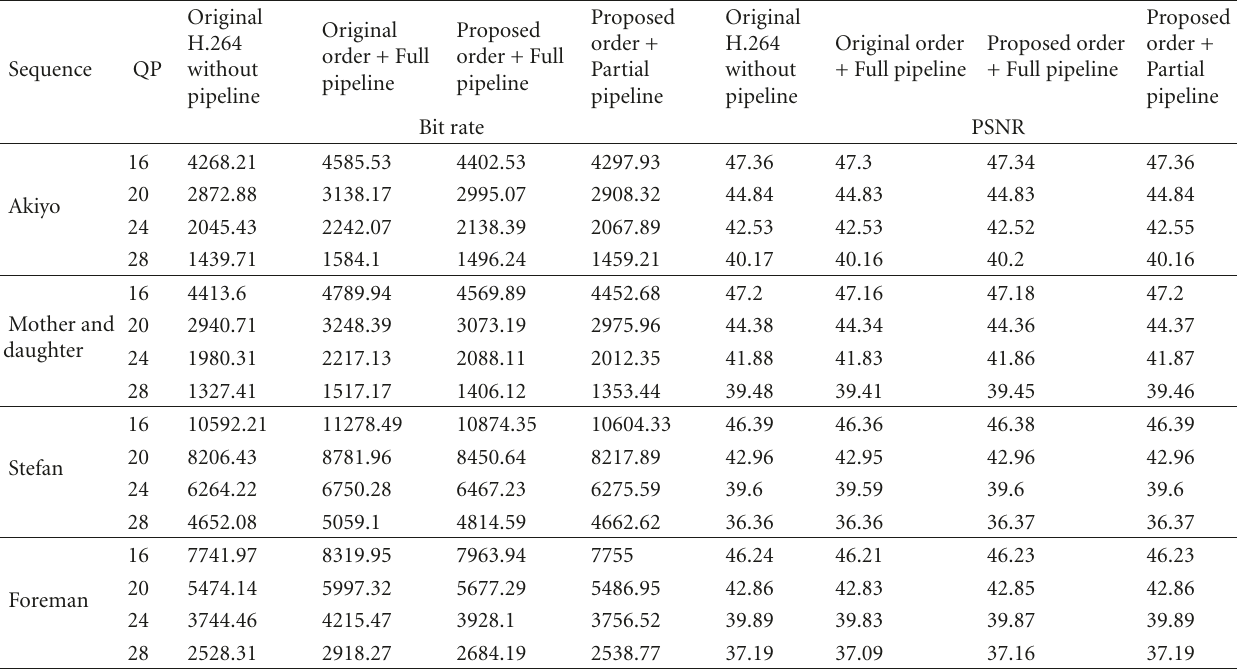
Table 1: Bitrate and PSNR comparison of various pipelined